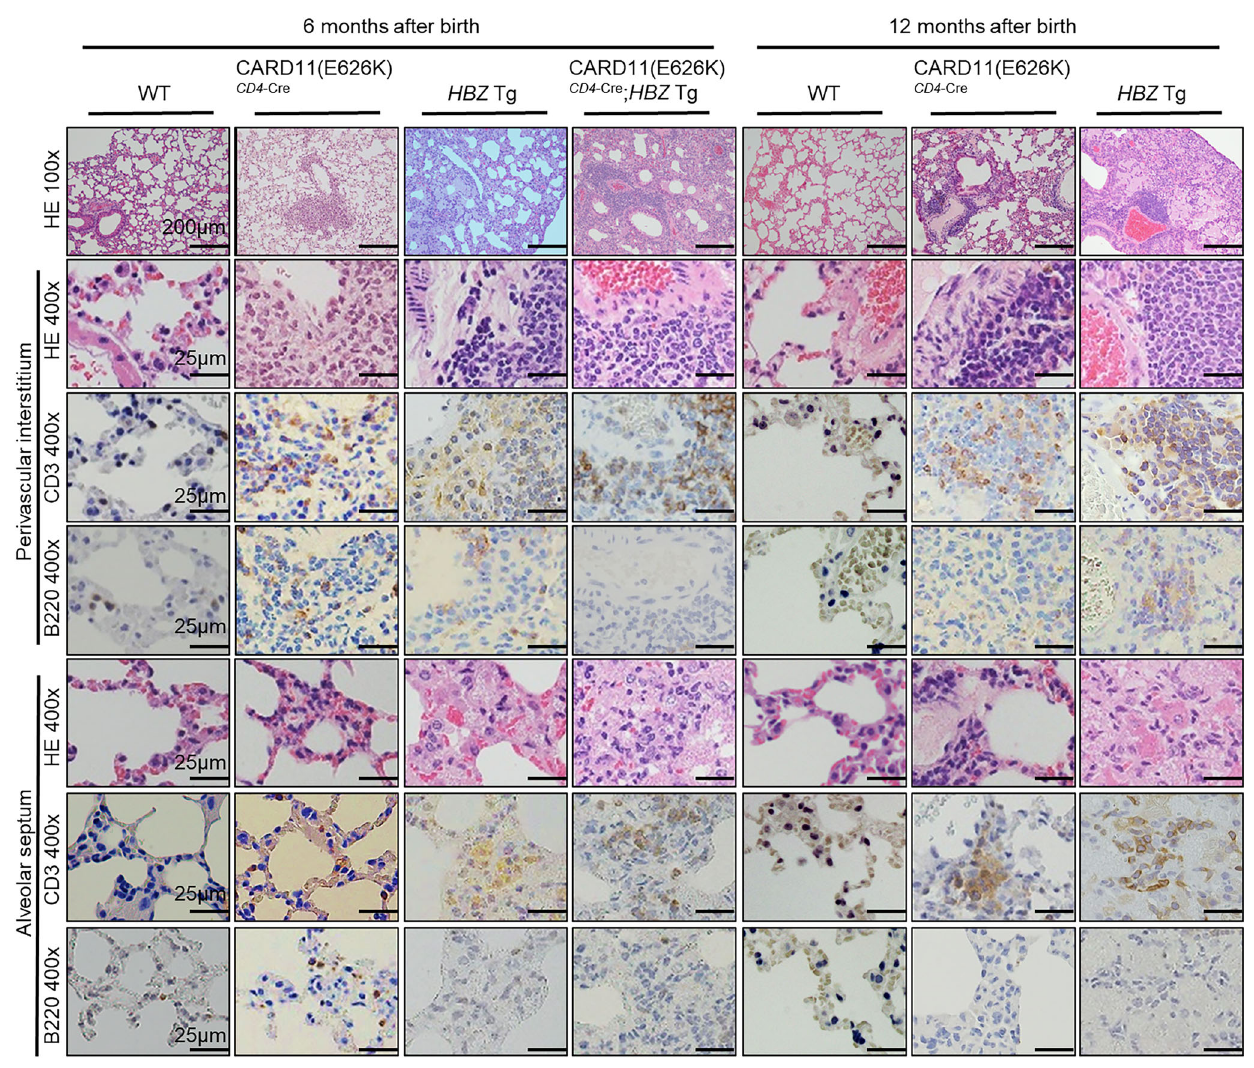
Fig. 4 Lymphocyte in fi ltration into the lung in mutant mice. Histologic analysis of the lung at 6 and 12 months after birth ( n = 5 for each mouse type). Lungs were stained with hematoxylin and eosin (HE), as well as anti-CD3 and anti-B220 antibodies. Lymphocyte in fi ltration into the lung perivascular interstitium and alveolar septa is observed in mutant mice at 6 and 12